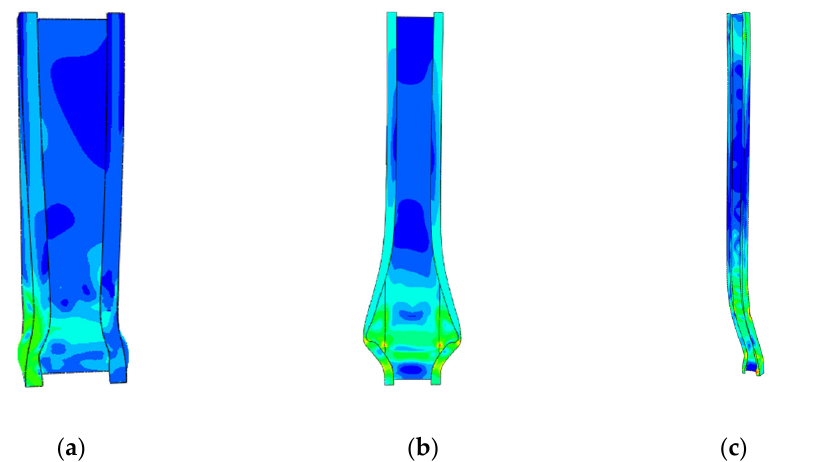
Figure 7. Failure modes. ( a ) Local buckling of C4-BC-L15-70-02; ( b ) Distortional buckling of C3-BC- L30-60-03; ( c ) Global buckling of C1-BC-L70-40-02.